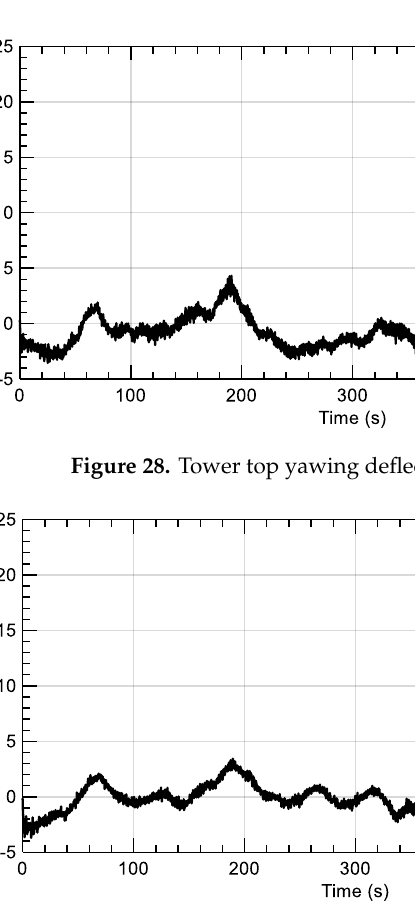
Figure 29. Tower top yawing deflection: turb. class C.